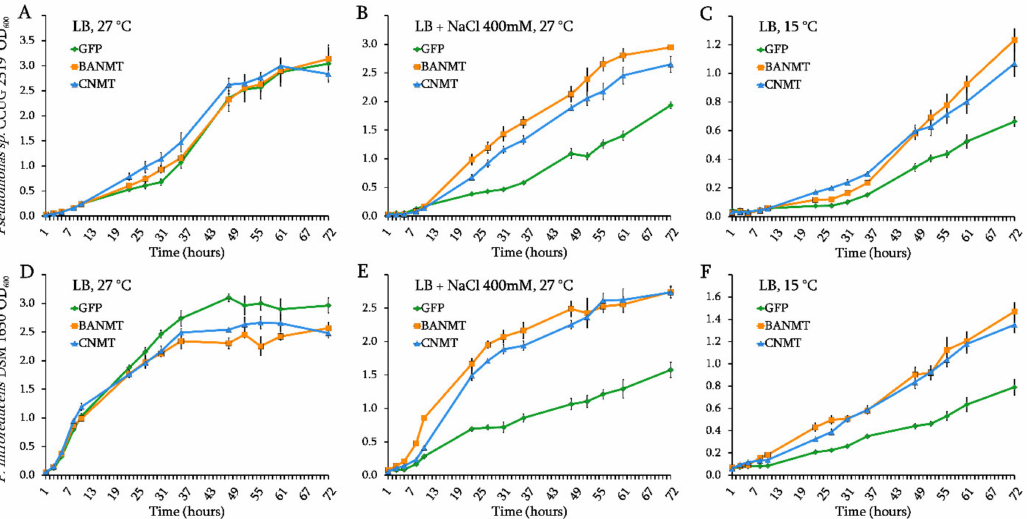
Figure 2. The effect of eGFP , CNMT and LlBANMT gene expression on the growth dynamics of Pseudomonas sp. CCUG2519 ( A – C ) and P. nitroreducens DSM1650 ( D – F ) strains under the control conditions (LB, 27 ◦ C), high salinity (LB + 400mM NaCl), and cold stress (LB, 15 ◦ C). Data are the means ± standard errors of the mean of three independent biological experiments with three technical replicates